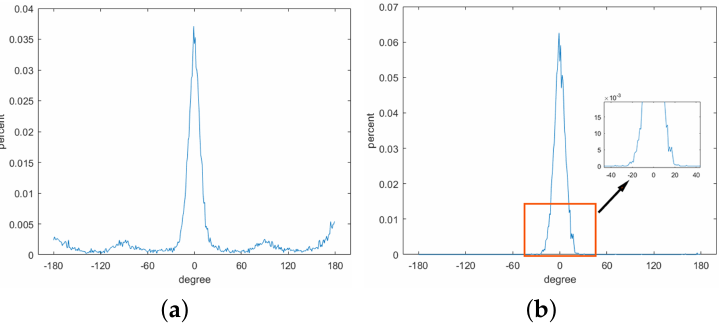
Figure 1. ( a ) orientation error (OE) distribution of all of the corresponding points; ( b ) OE distribution of the correctly-matched